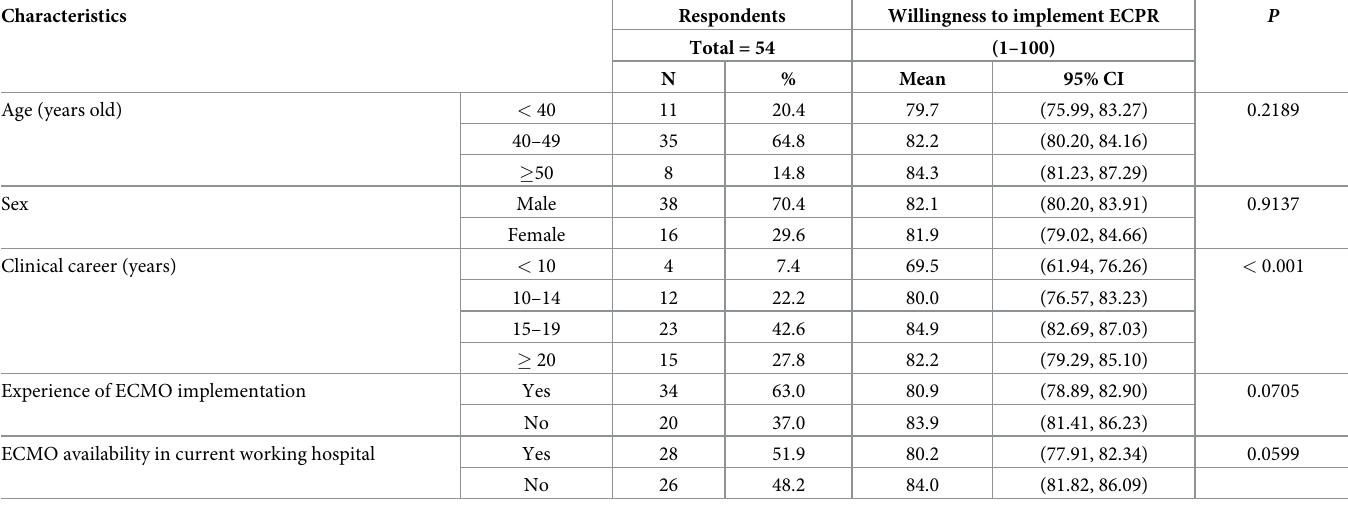
Table 2. The willingness scores for ECMO application according to the characteristics of the Eps.